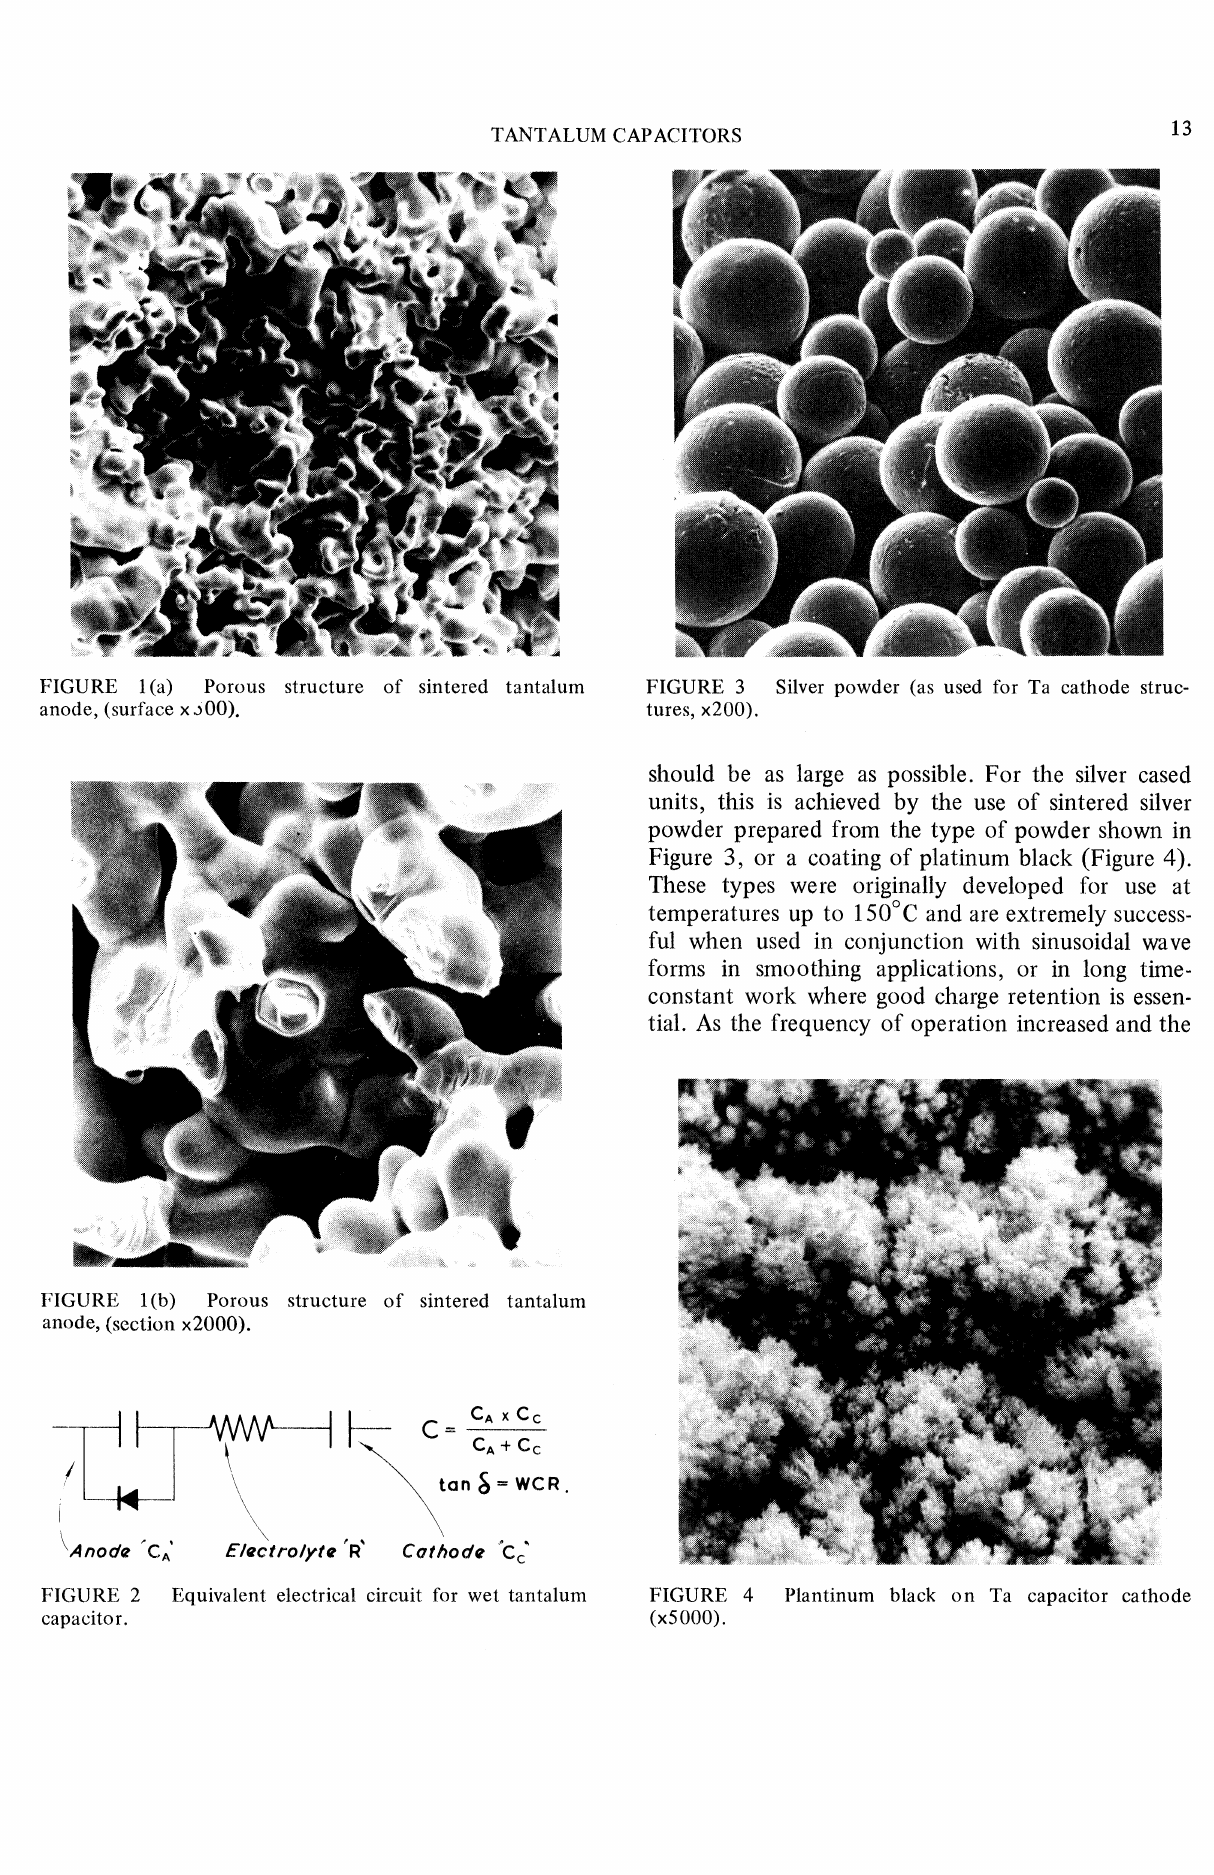
FIGURE 4 Plantinum black on Ta capacitor cathode